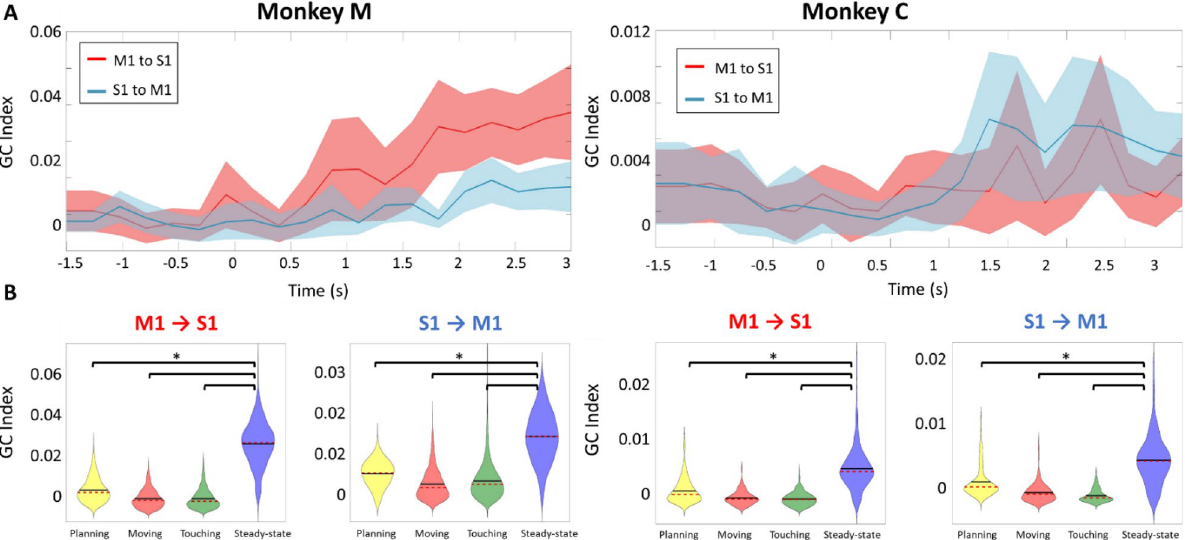
Figure 4. Channel-averaged Granger causality shows bidirectional S1–M1 communication during the steady-state hand squeeze. Left: Monkey M. Right: Monkey C. All trials were aligned to the onset of touch (t = 0). ( A ) Beta-band averaged, and channel-averaged Granger causality index computed using a sliding window (length = 500 ms, step = 250 ms) for each direction of putative cortical communication. The p-value was calculated from random permutation test (# permutations = 200). We chose a target α = 0.05 and used FDR correction for multiple testing. M1 → S1, Red shadowed trace; S1 → M1, Blue shadowed trace. The bold red and blue lines showed the mean of GC values across LFP pairs, and the shaded regions denoted one standard deviation of the data. ( B ) Violin plots of the distribution in the GC index from the pool of 1310 selected channel pairs in monkey M and 898 pairs in monkey C for the four stages of the task. The GC values during the Steady- state are confirmed to be the largest (*p = 10 –3 , two-sample